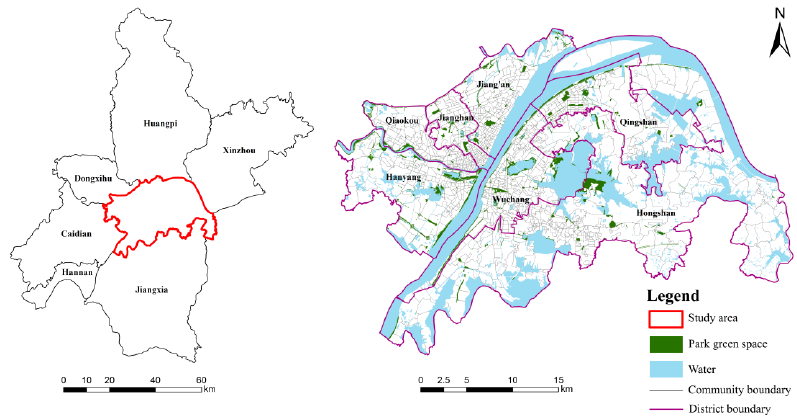
Figure 1. The study area and spatial distribution of park green space in Wuhan. Local governments have dedicated time and efforts to green benefits. Before the founding of the People’s Republic of China, Wuhan did not form a complete urban green space system. After the implementation of the Design Plan of Wuhan Special City in 1929, urban parks began to be planned systematically as a special project. This period was called the exploration period of the park green space policy (Figure 2). In the 1950s, Wuhan City formulated a three-town-integrated urban master plan, which started the germination period of urban green space system planning and construction. Subsequently, due to the rise and fall of politics and natural disasters, the construction of green space spaces were occupied, demolished and destroyed. After the reform and opening-up, urban Wuhan have now entered a period of stable and rapid development. During this period, urban greening mainly emphasised the quota index such as green space ratio, green space coverage rate and per capita public green area. The sustainable development of cities needed to evolve towards an ecological pattern. In 1995, the Wuhan City Master Plan (1996–2020) proposed to build Wuhan into an ecological city with landscapes and gardens rich in waterfront characteristics. In 2005, Wuhan was awarded the title of “National Garden City”. Based on the principle of people-oriented and fair sharing, in order to promote the spatial equity in park green space, the Wuhan Natural Resources and Planning Bureau compiled the Planning for the Green Space System in the Main Urban Area of